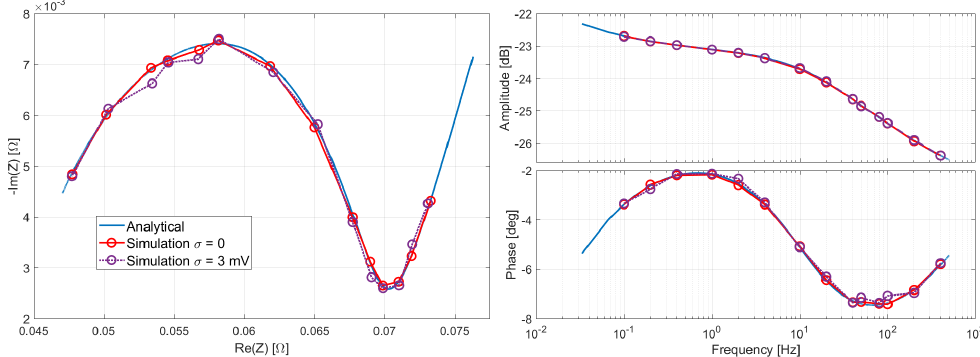
Figure 7. ( Left ): Nyquist plot of the simulated FIR frequency response compared with the analytical response. ( Right ): Bode plots of amplitude and phase of the FIR frequency response.